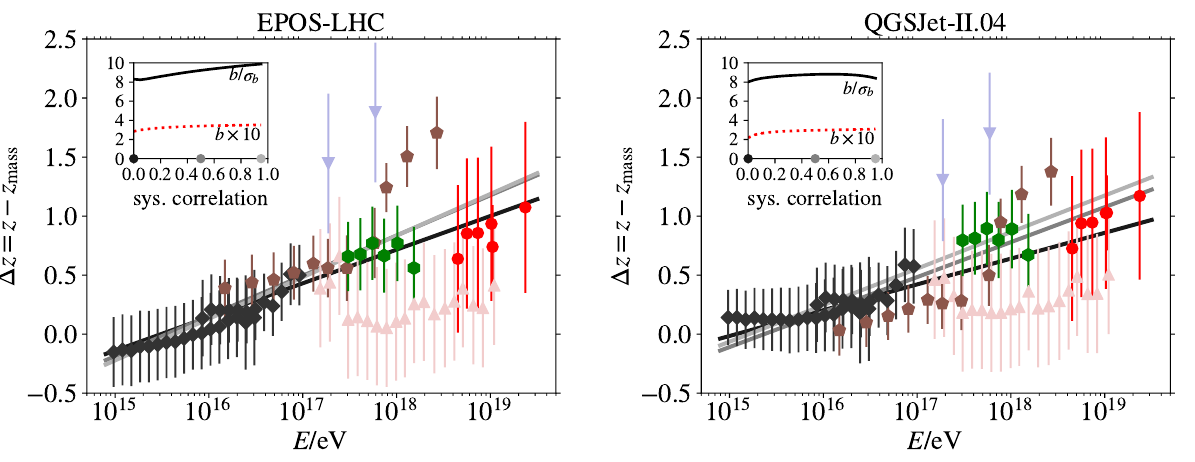
Figure 10. Fits of straight lines ∆ z = a + b (log ( E / eV) − 16) to the data points. Shown in the inset are the slope b and its deviation 10 from zero in standard deviations for an assumed correlation of the point-wise uncertainties within each experiment. Examples of the fitted lines are shown for a correlation of 0, 0.5, and 0.95 in varying shades of gray.